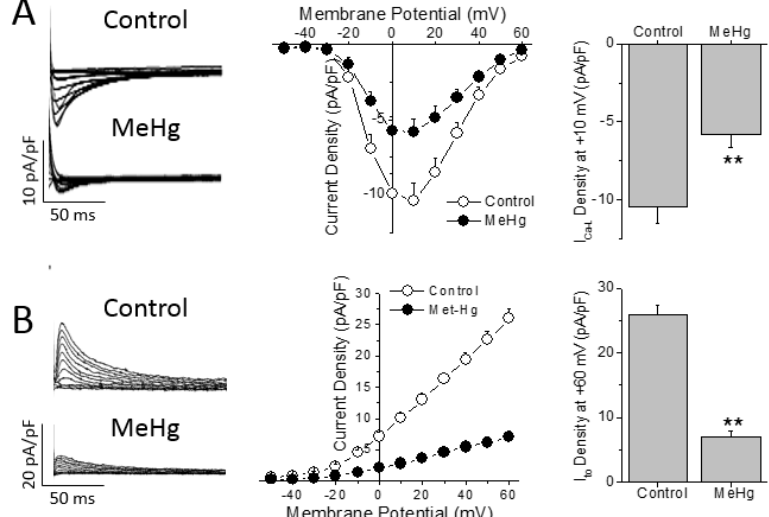
Figure 3. MeHg treatment reduces the transient outward K + and the L-type Ca 2 + currents in ventricular myocytes. ( A ) I Ca-L currents were recorded at voltages from − 50 to + 60 mV in ventricular myocytes isolated from animals after 4 weeks in control conditions or treated with MeHg. Current–voltage relationship obtained in myocytes from animals treated with vehicle (open symbols, n = 7) or with MeHg (filled symbols, n = 6). ( B ) I to traces recorded at potentials between − 50 and + 60 mV in ventricular myocytes isolated from animals after 4 weeks in control conditions or treated with MeHg. Current–voltage relationship obtained in myocytes from animals treated with vehicle (open symbols, n = 18) or with MeHg (filled symbols, n = 14). ** p < 0.01.